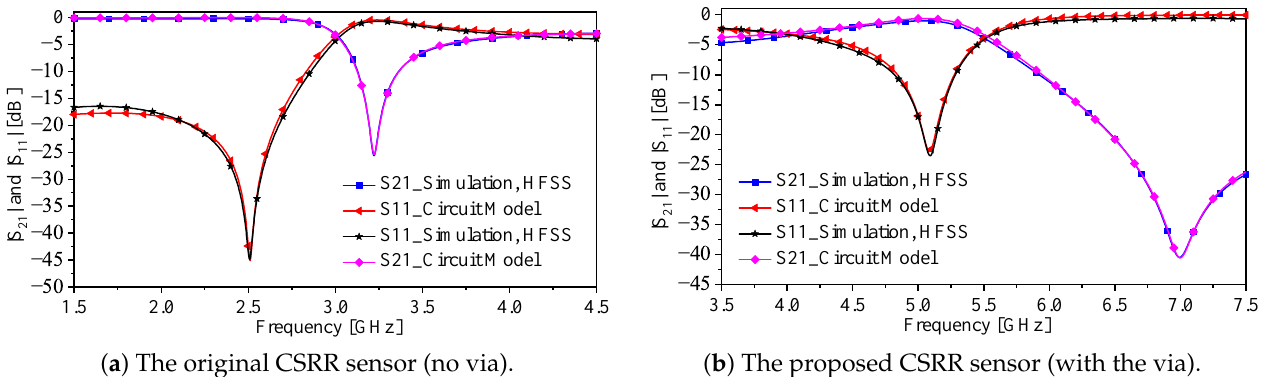
( b ) The proposed CSRR sensor (with the via). Figure 5. ( a ) The response ( | S 11 | [dB] and | S 21 | [dB]) of the original ( b ) and the proposed CSRR (L = 7.5 mm) extracted using the simulation and the equivalent-circuit model that is presented in Figures 1c and 3c,